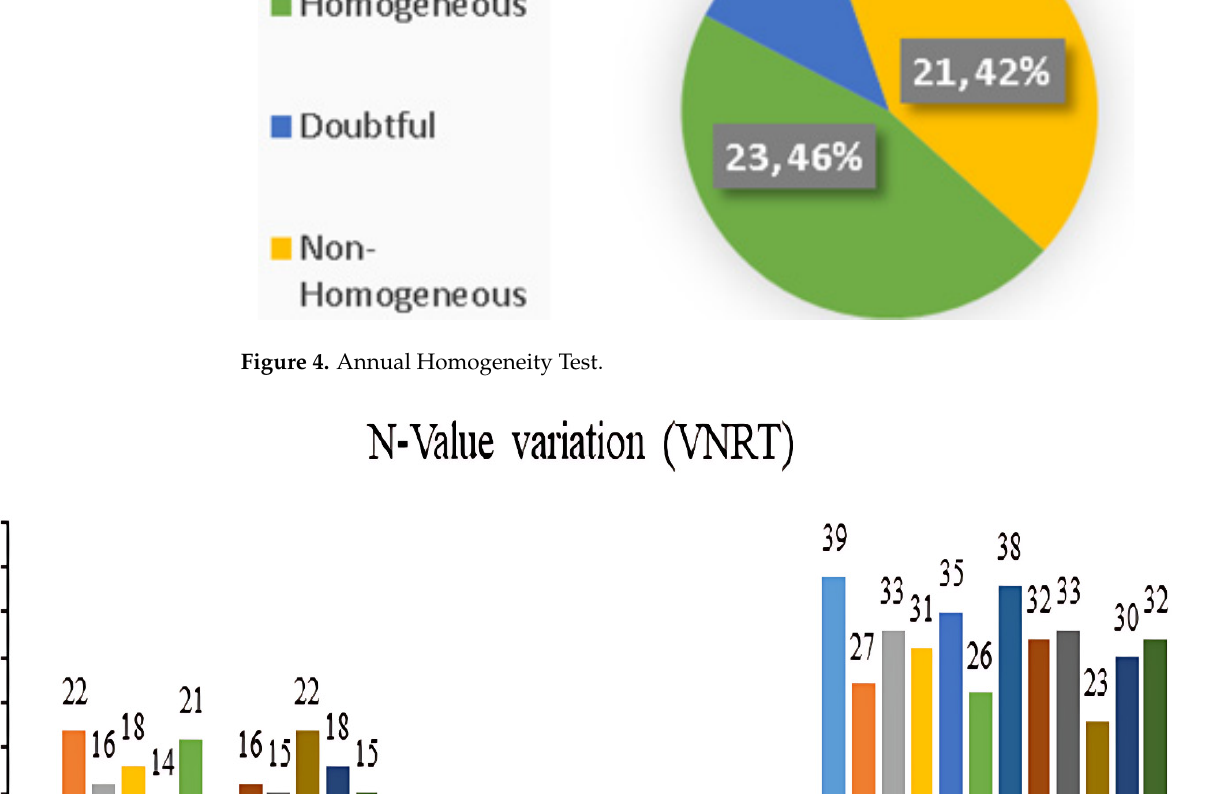
Figure 5. Month-wise variation of N-Value (Von Neumann Ratio